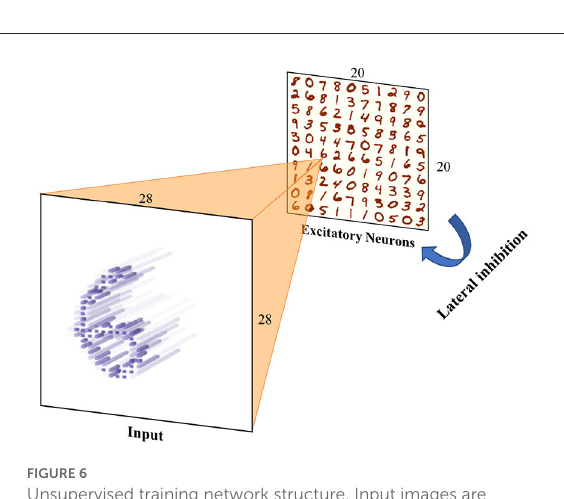
FIGURE6 Unsupervised training network structure. Input images are encoded into spikes and then fed into the spiking neural network. The network includes an input layer and an output layer (excitation layer), there are synapses with learnable weights between them. Any neuron in the output layer has inhibitory connections with fixed weights to the others to achieve lateral